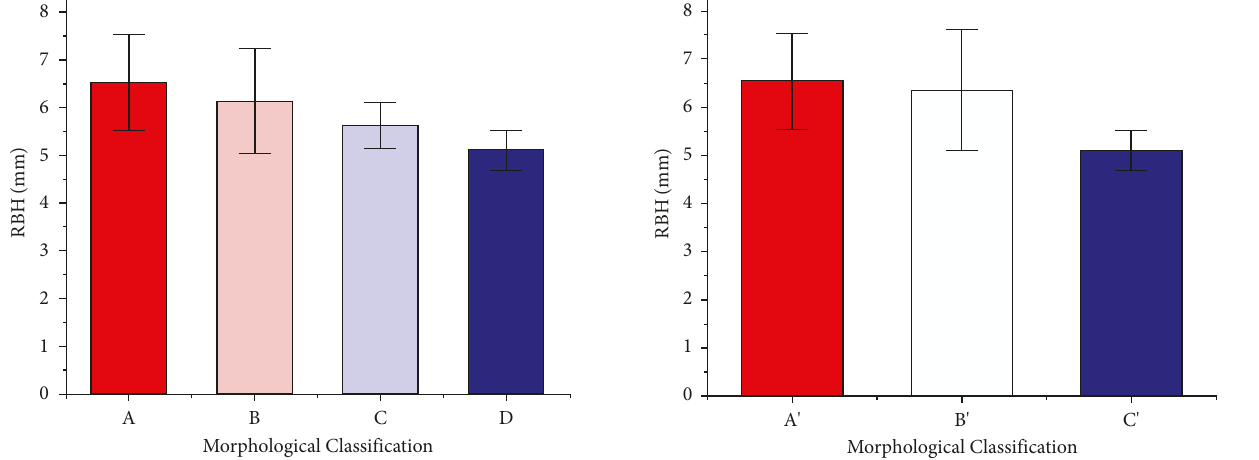
Figure 6: The mean RBH of different morphological classifications based on the sagittal plane ( p < 0 . 05; power � 0.83). (a) Type A: tent type; (b) Type B: flat type; (c) Type C: one-sided dehiscence type; (d) Type D: two-sided dehiscence type.